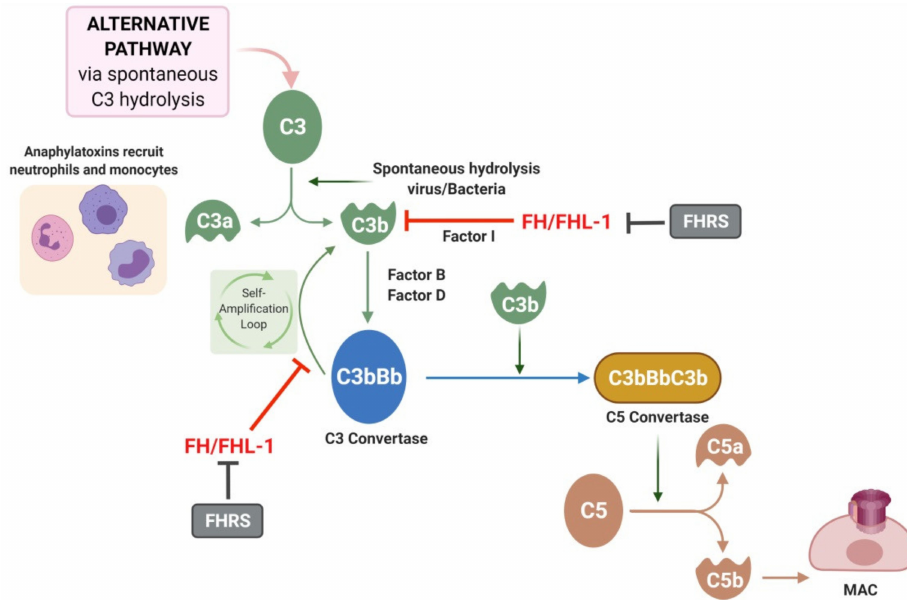
Figure 2. Alternative pathway and role of complement Factor H (FH). The alternative pathway is triggered by the spontaneous hydrolysis of C3 which forms C3a and C3b. C3b is able to interact with factor B and factor D creating the C3bBb molecule also known as C3 convertase. The C3 convertase of the alternative pathway triggers an amplification loop, with further hydrolysis of C3. Ultimately, C3b can join the C3 convertase to form C3bBbC3B or C5 convertase, which cleaves C5 to C5a and C5b. C5b leads to formation of the membrane attack complex (MAC). FH/FHL-1 can interact with C3b molecules or with the C3 convertase complex avoiding the amplification loop. FH-related proteins (FHRS) compete with FH for C3b binding and inhibit Factor I-mediated C3b